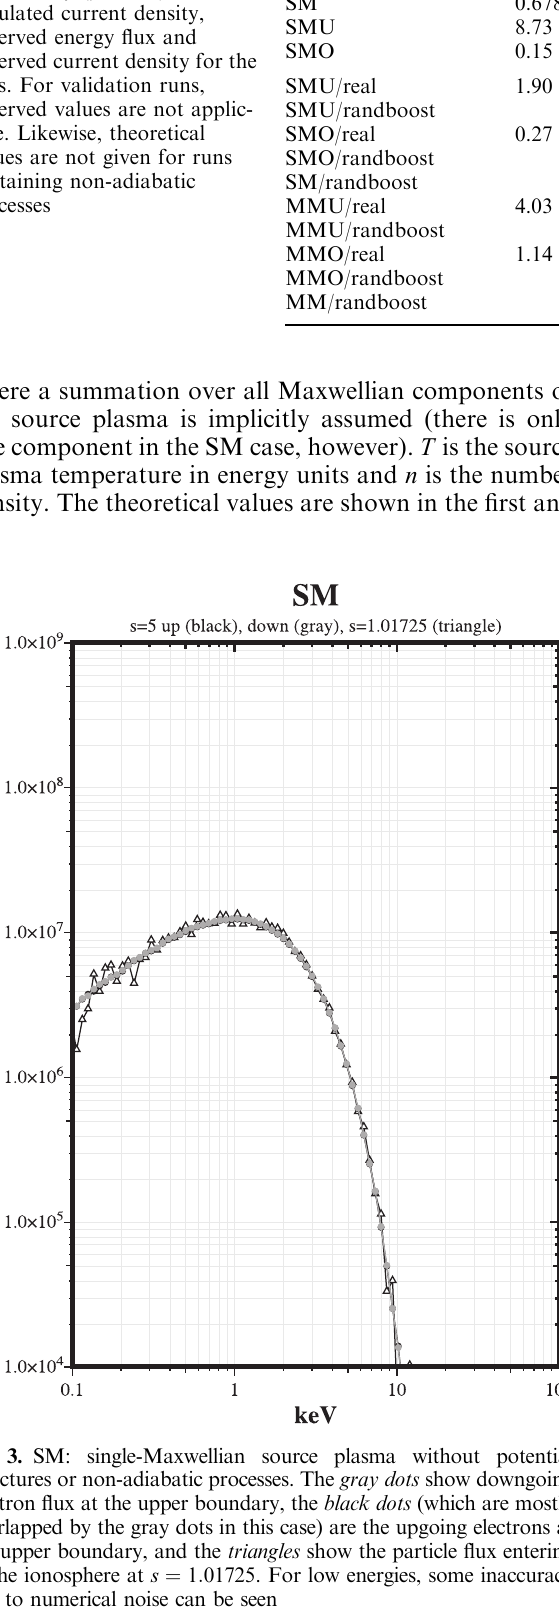
Table 2. Theoretically expected energy flux (mWm ) 2 ), simula- ted energy flux, expected cur- rent density ( l A m ) 2 ), simulated current density, observed energy flux and observed current density for the runs. For validation runs, observed values are not applic- able. Likewise, theoretical values are not given for runs containing non-adiabatic processes